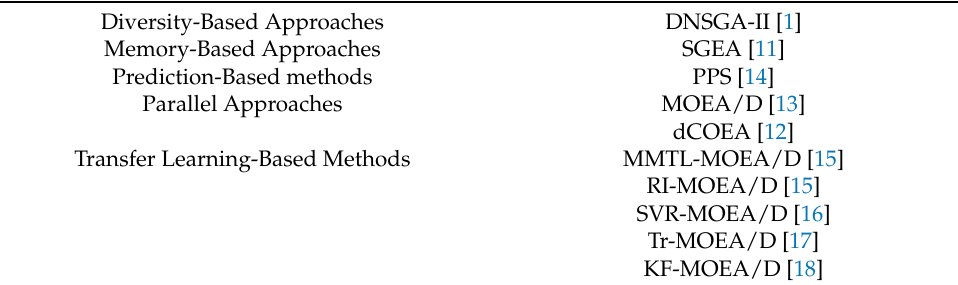
Table 1. Classification of the MOEAs for